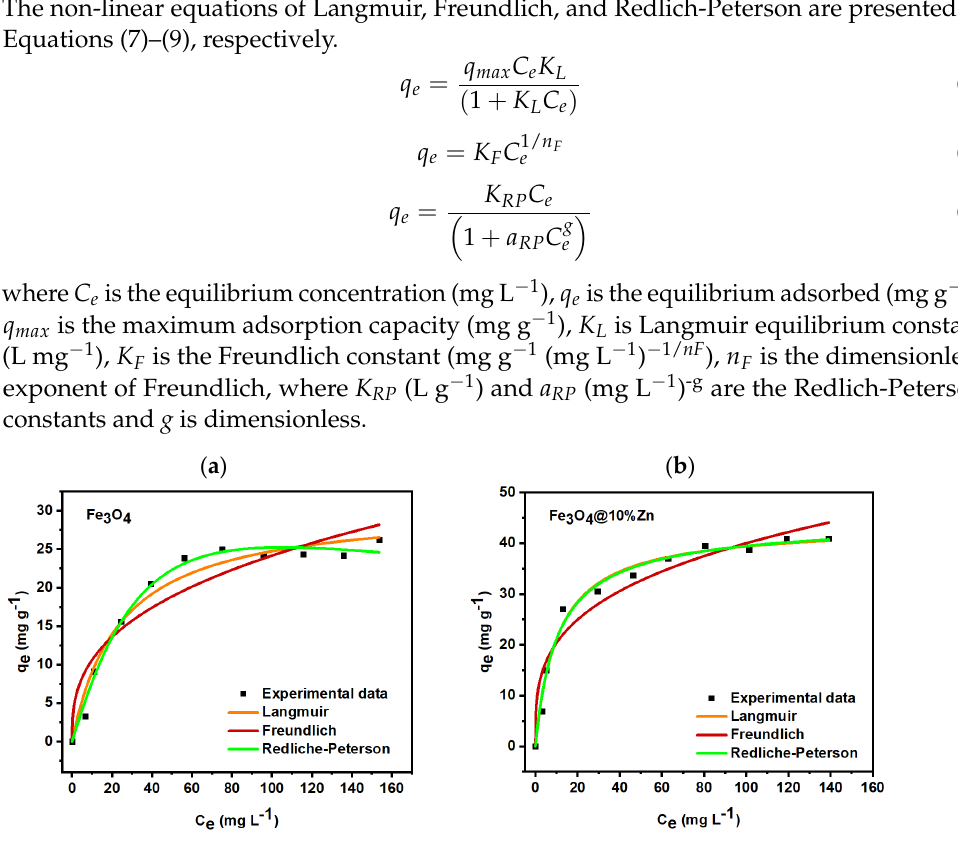
Figure 12. Isotherm modeling and experimental data for ( a ) Fe 3 O 4 and ( b ) Fe 3 O 4 @10%Zn nanoparticles. Table 4. Adsorption parameters.